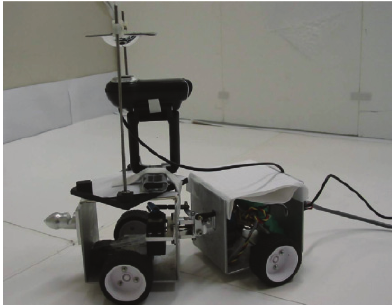
Figure 8: A general view of the built robot, including the docking connector and the visual